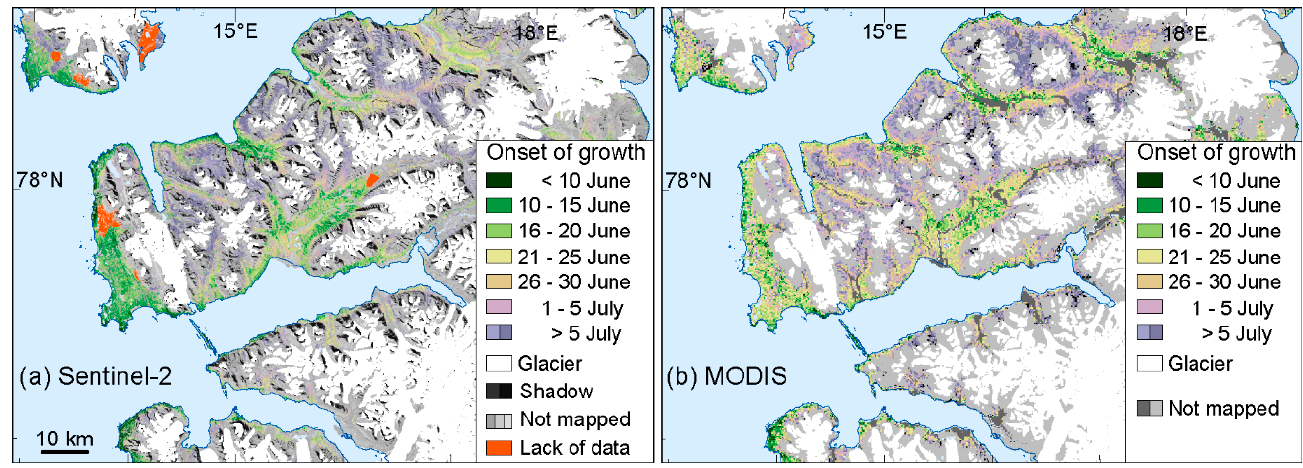
Figure 3. Onset of vegetation growth in 2019 for central Svalbard. Mapped with ( a ) time series of cloud-free Sentinel-2 NDVI data (extracted from Karlsen et al. [16]) and ( b ) mapped with time series of MODIS NDVI data.